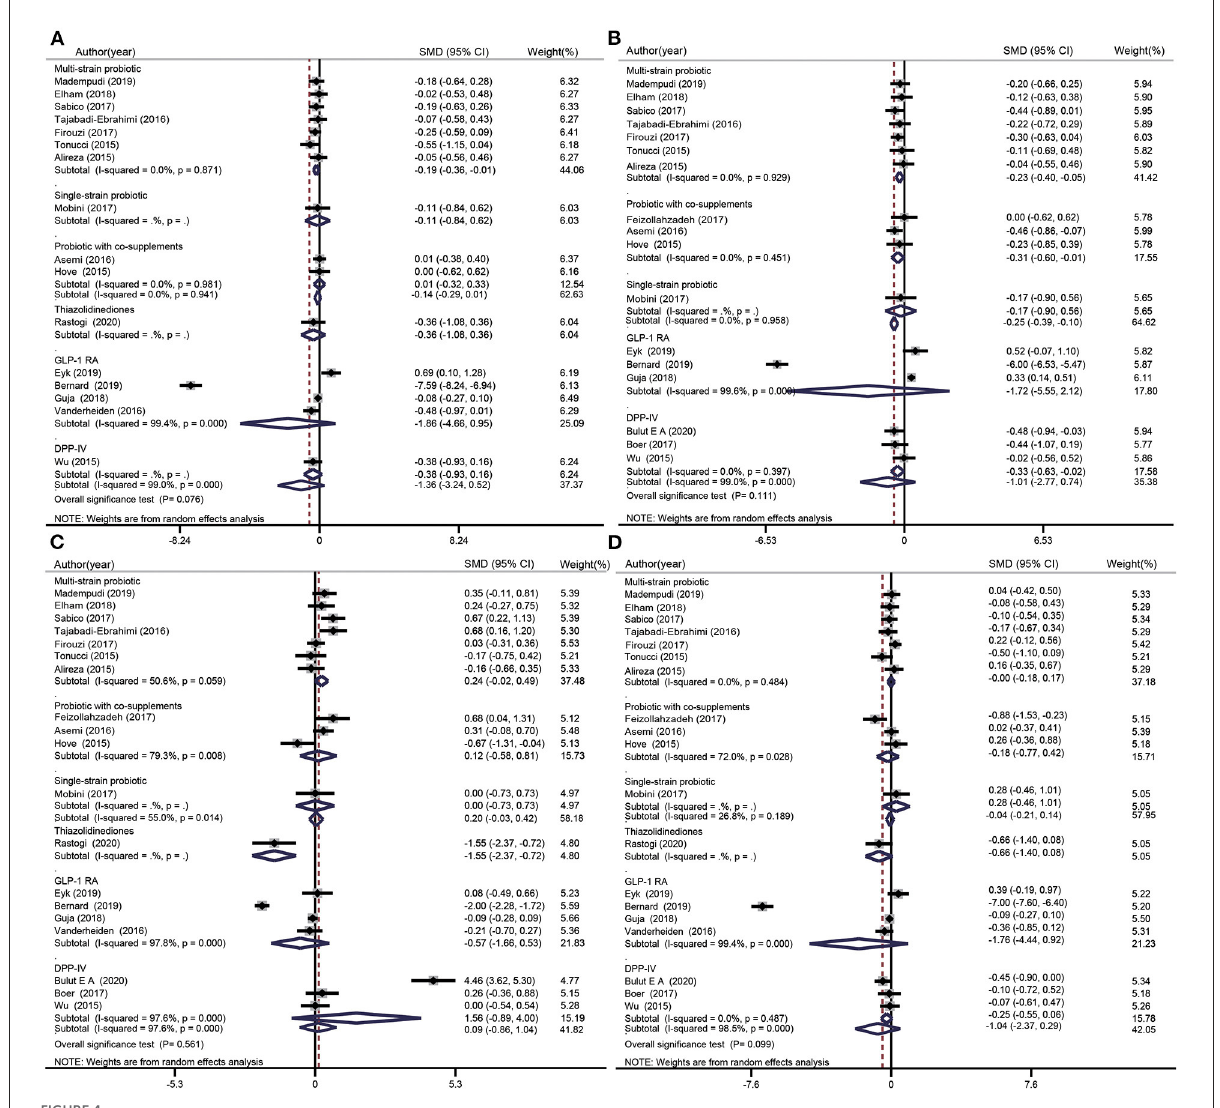
FIGURE4 Forest plots for the effect of probiotics supplementation and glucose-lowering drugs on TC (mg/dL) (A) , TG (mg/dL) (B) , HDL-C (mg/dL) (C) , and LDL-C(mg/dL) (D) compared to placebo in pooled analysis. For each study, the solid black diamonds represent the point estimate of the intervention effect. The horizontal line joins the lower and upper limits of the 95% CI of this effect. The open diamonds represent the subgroup and overall SMD determined with a random-effects model.